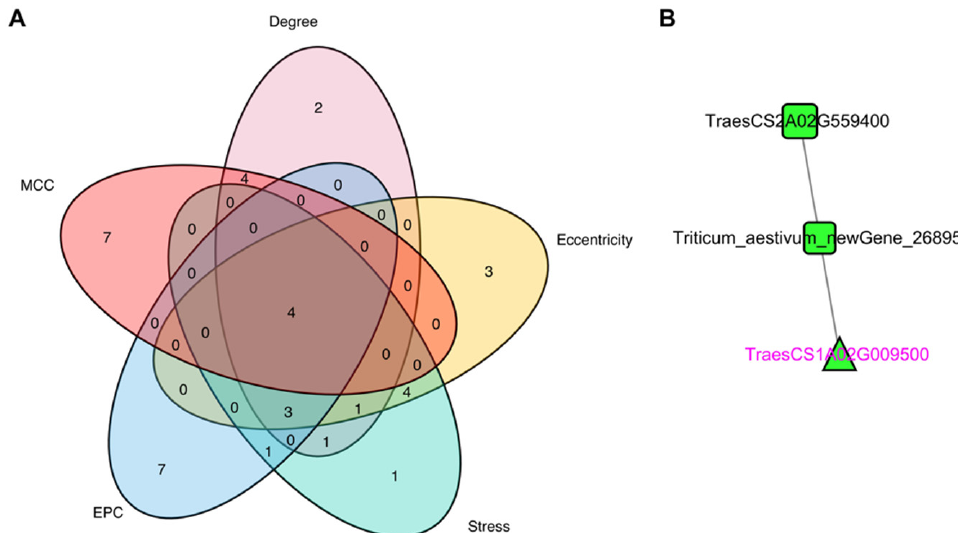
Figure 6. Hub genes and Hub modules: ( A ). Venn analysis showed that the four hub genes listed in Table 1 could be repeatedly screened by five approaches from cytoHubba with different analysis methods (Degree, EPC, EcCentricity, Stress, and MCC). ( B ). The screened hub PPI module 5 by MCODE. Note: the triangles indicate the seed DEGs. The complete results are shown in Figure S6. EPC, Edge Percolated Component; MCC, Maximal Clique Centrality; PPI, Protein–Protein Interaction; MCODE, Molecular COmplex Detection; DEGs, Differentially Expressed Genes. Table 1. The common hub DEGs in the PPI network screened by centrality methods.